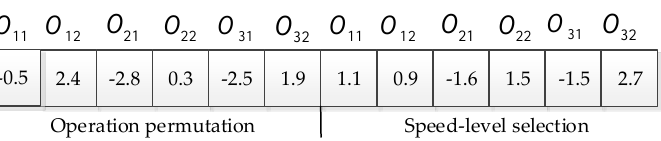
Figure 3. Individual position vector.